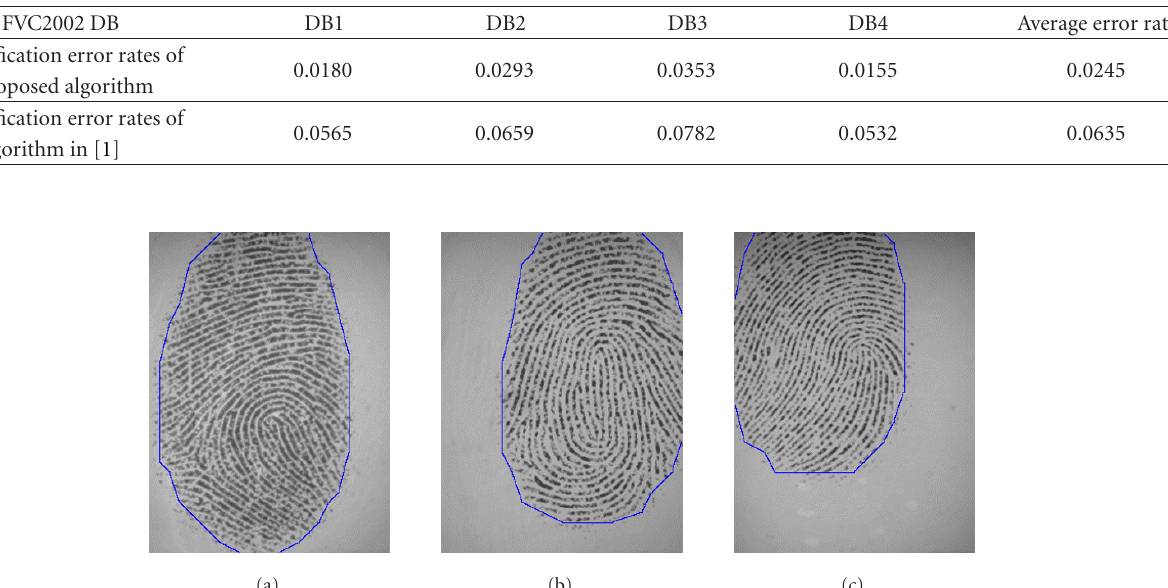
Table 6: The comparison of error rates of the proposed algorithm and the algorithm in [1] on FVC2002 DB.